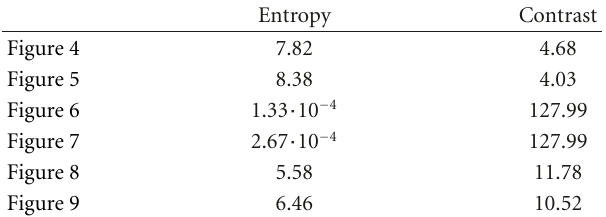
Table 2: Focusing indicators for the ISAR images corresponding to the simulated data.